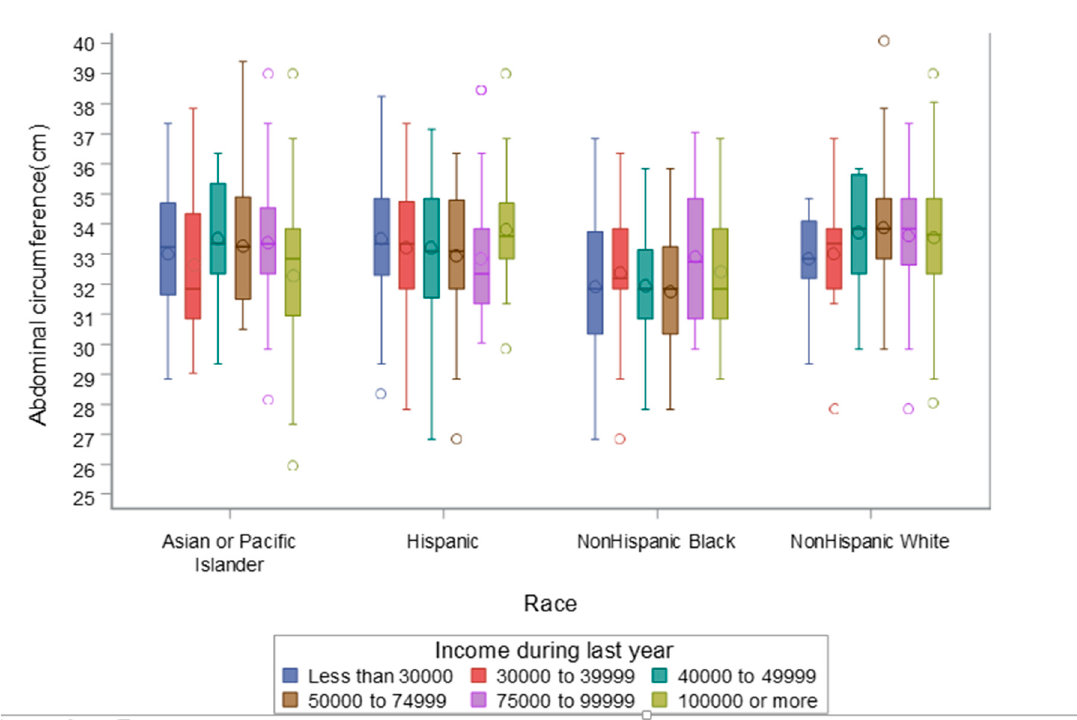
Table 4. Type III sum of squares p-values for race by socioeconomic interactions.